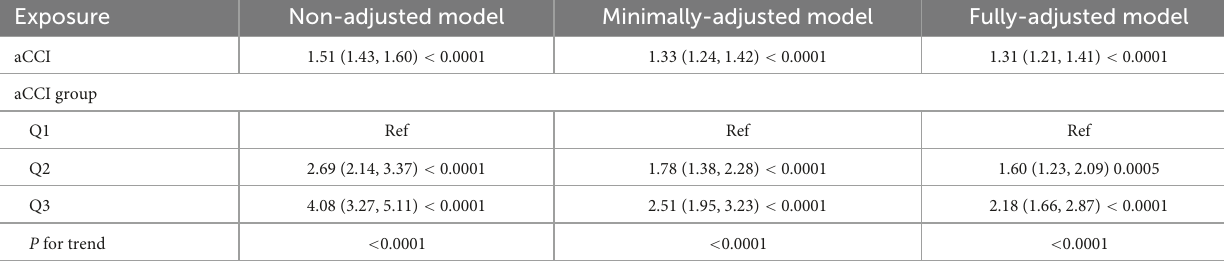
TABLE 3 Multivariate results by Cox regression.